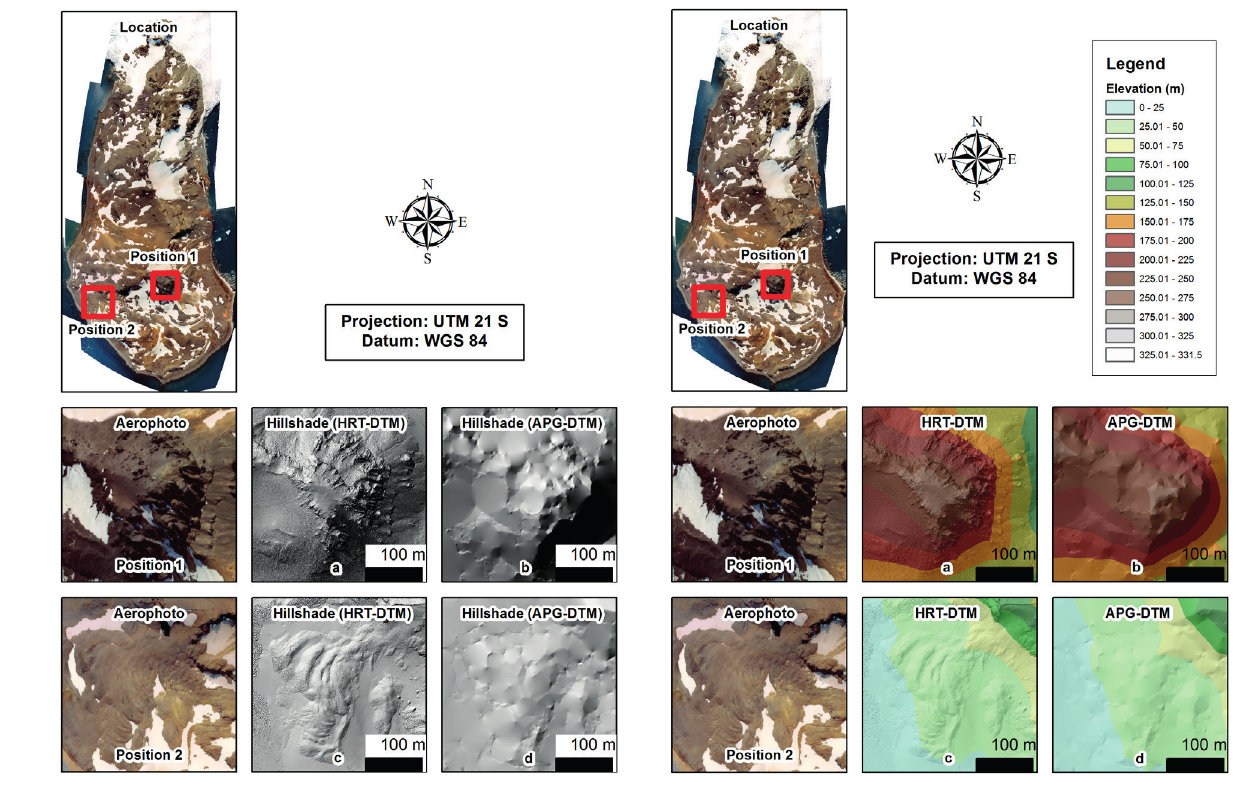
Figure 8 - Illustrative representation of the Hillshade for the HRT-DTM (a and c) and the APG-DTM (b and d) in two different positions (Aerophotos adapted from Francelino M.R., unpublished data).